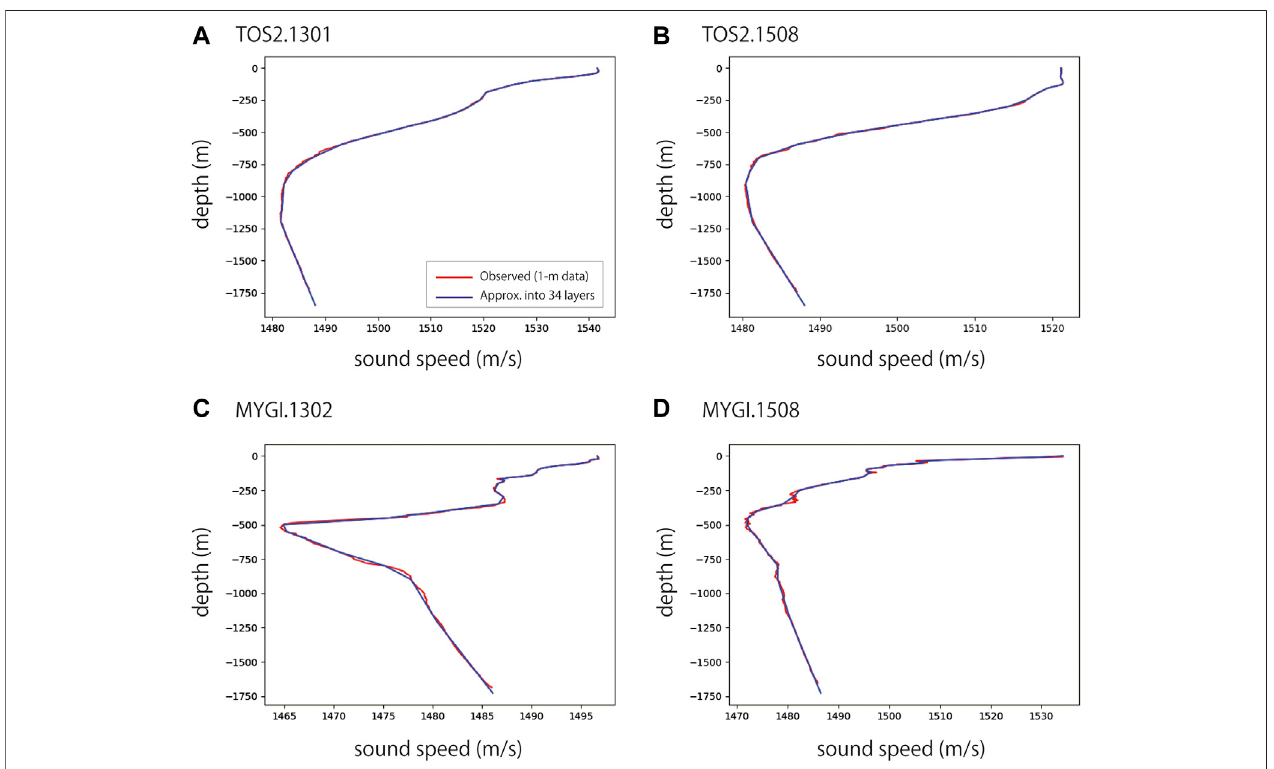
FIGURE5| Referencesoundspeedpro fi les(bluelines)forepochs (A) TOS2.1301(January2013), (B) TOS2.1508(August2015), (C) MYGI.1302(February2013), and (D) MYGI.1508 (August 2015). Red lines indicate 1-m sound speed pro fi les obtained from the 1-m layered XBT/XCTD data.